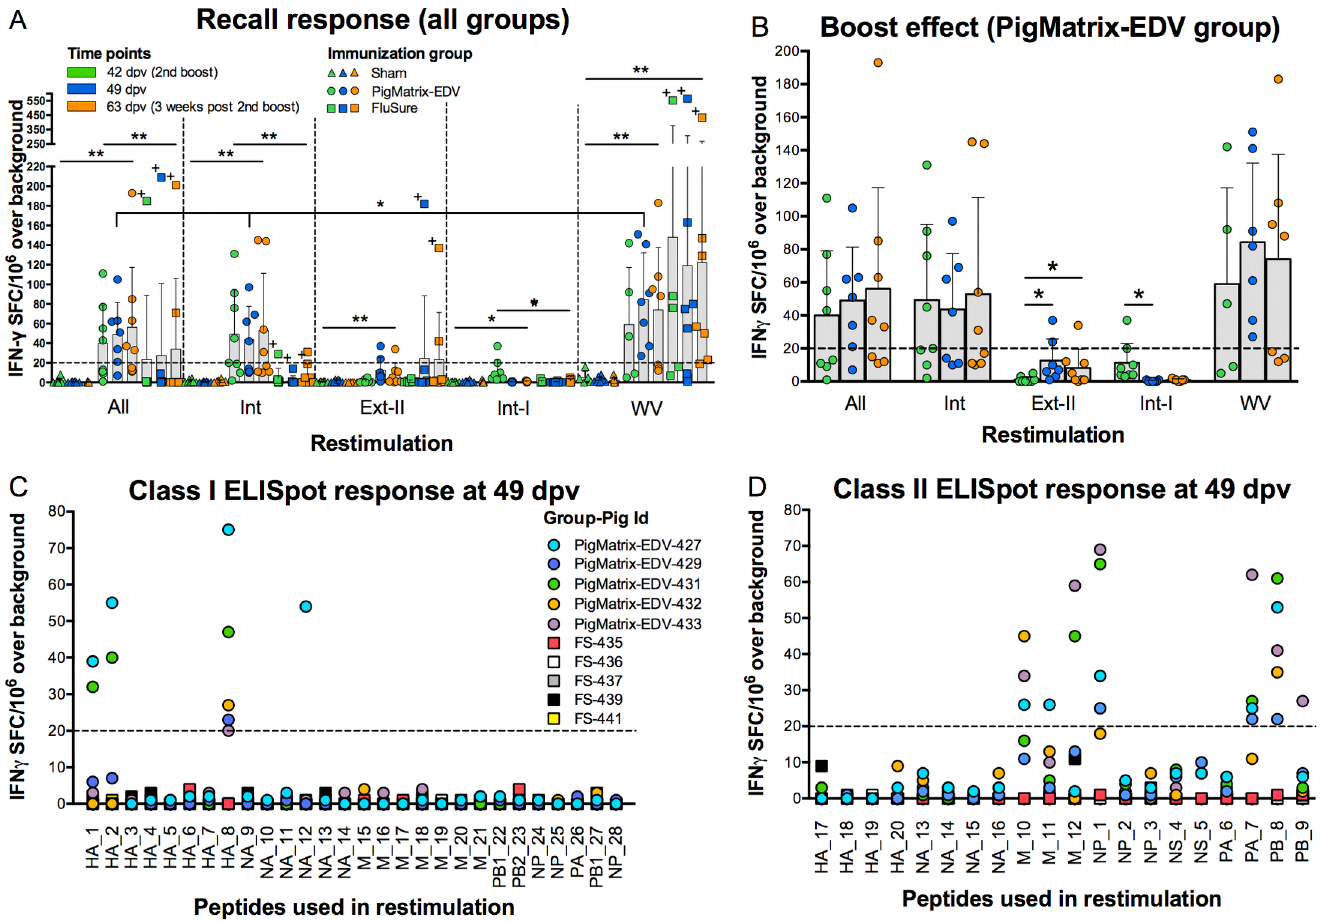
Fig 4. Peptide immunogenicity measured by IFN γ ELISpot. (A) PBMC (2.5 x 10 5 ) isolated at three different time points (42, 49, and 63 dpv) from pigs immunized with empty plasmid (Sham), epitope-driven DNA vaccine (PigMatrix-EDV) and commercial vaccine (FluSure) were restimulated with pooled peptides (All, Int, Ext-II, and Int-I) at 10 μ g/mL and whole virus (WV). The number of epitope-specific IFN γ spot forming cells (SFC) induced by the pools were measured using ELISpot assays. “ High responder pig ” (FS-442) is marked with +. (B) To evaluate vaccine boost effect, IFN γ responses to pooled peptides were measured at three different time points. For A and B, SFC over background, adjusted to spots per 10 6 of PBMC seeded, are represented with bars indicating means and error bars indicating standard deviation (SD). Pooled peptide responses showing statistical significance when compared to Sham are indicated: ** p < 0.01, * p < 0.05. Significant statistical difference for PigMatrix-EDV between restimulations at 49 dpv is also shown. Same colors and shapes are used in both figures. (C) PBMC from pigs vaccinated with PigMatrix-EDV and FluSure were restimulated with individual class I peptides and (D) class II peptides one week after the second boost (49 dpv). For C and D, SFC over background per 10 6 PBMC are shown. A response was considered positive if the number of spots was greater than or equal to 20 SFC over background per 10 6 PBMCs (dashed